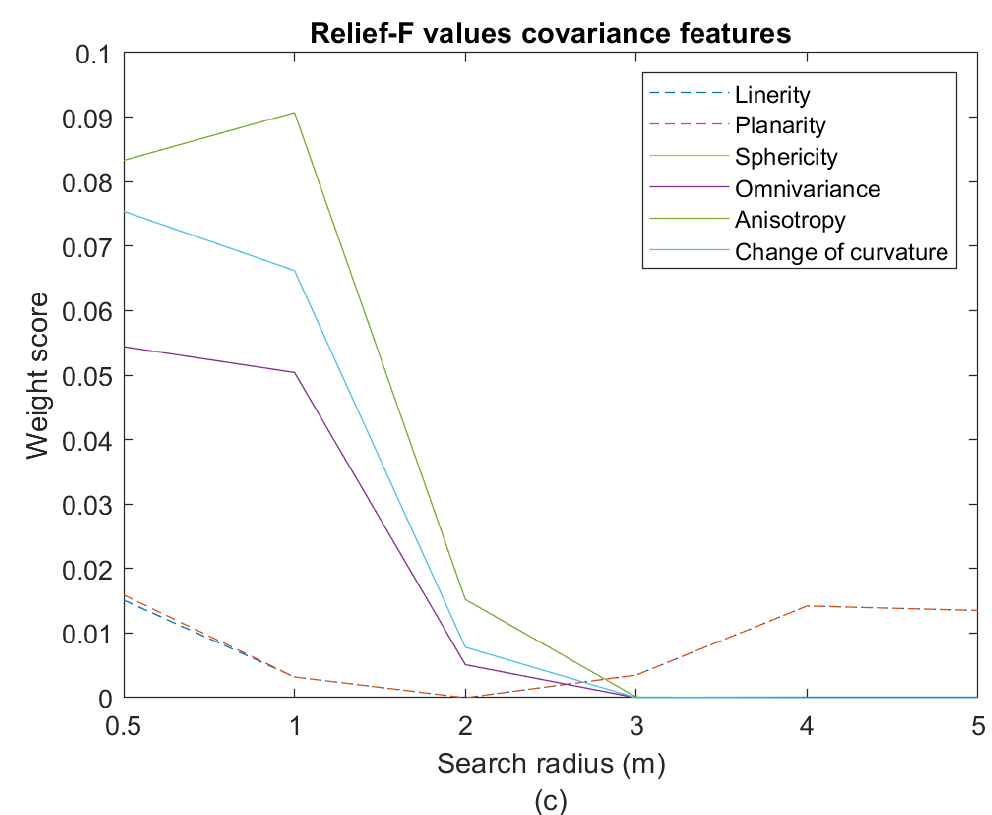
Figure 9. Relief-F weight scores for different search radii shown for each feature ( a ) Intensity features, ( b ) Relative position features, ( c ) Covariance features (Sphericity has similar weight scores as anisotropy and can not be seen). Features represented with dashed lines have not been used as predictors due to the 0.02 feature value